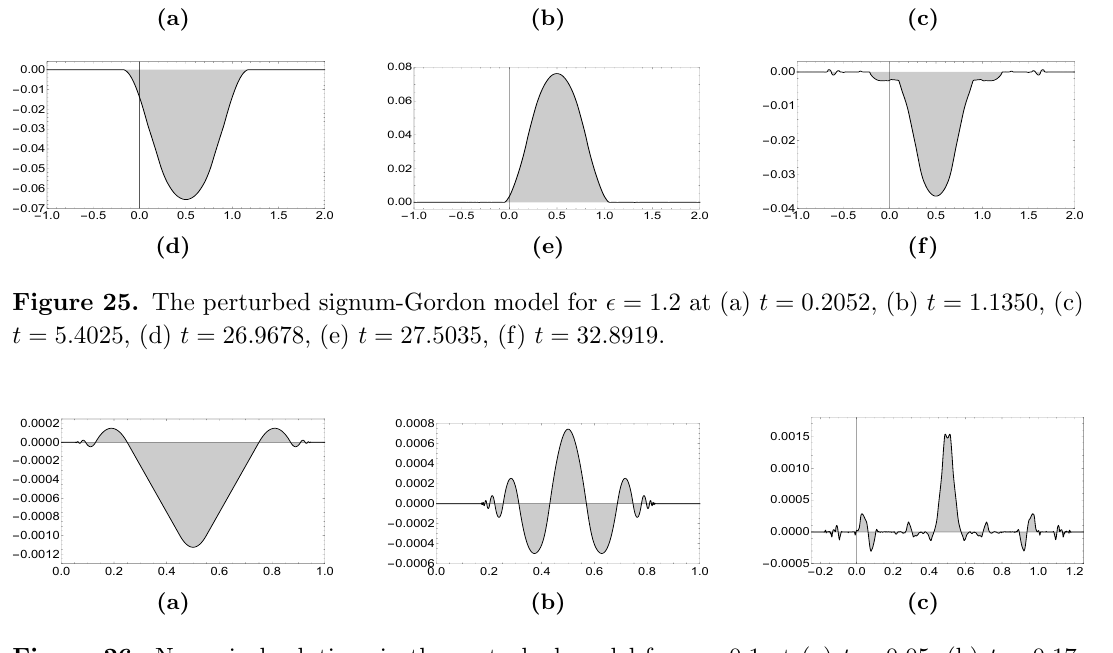
Figure 26. Numerical solutions in the perturbed model for (cid:15) = 0 : 1 at (a) t = 0 : 05, (b) t = 0 : 17, (c) t = 1 :